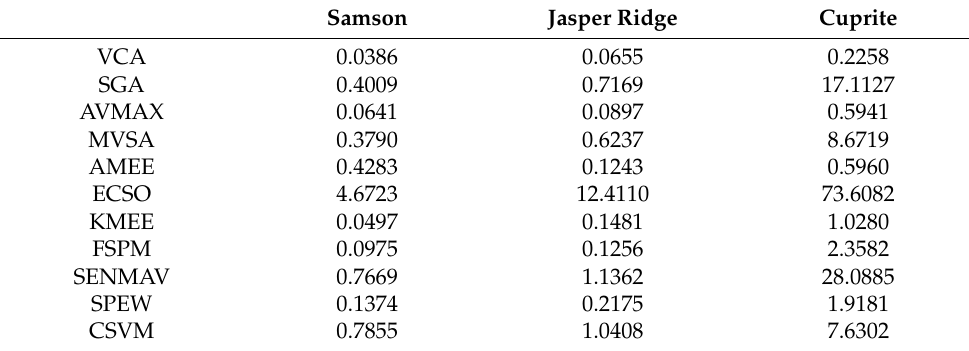
Table 4. CPU processing time of all test algorithms on Samson, Jasper Ridge and Cuprite datasets (in